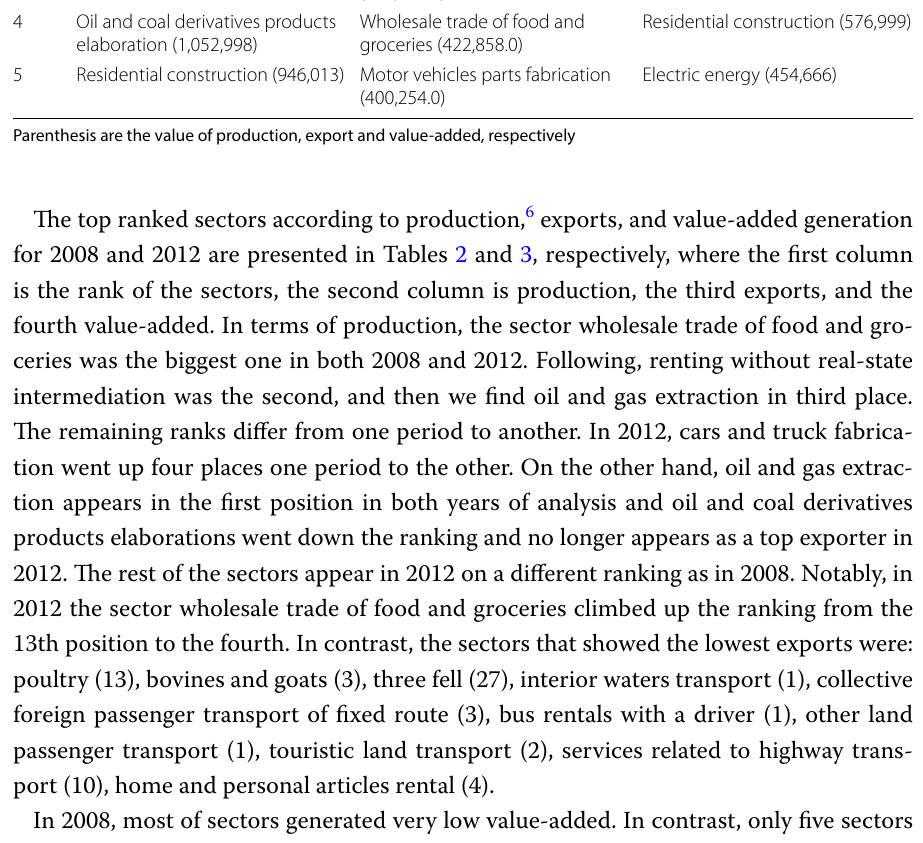
Parenthesis are the value of production, export and value‑added,